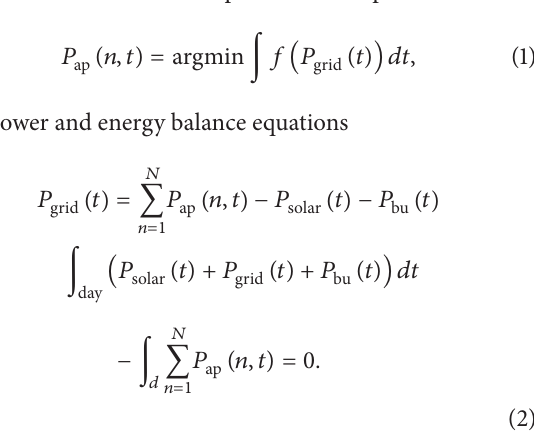
Figure 2: The potential of solar energy in Canada (Natural Resources